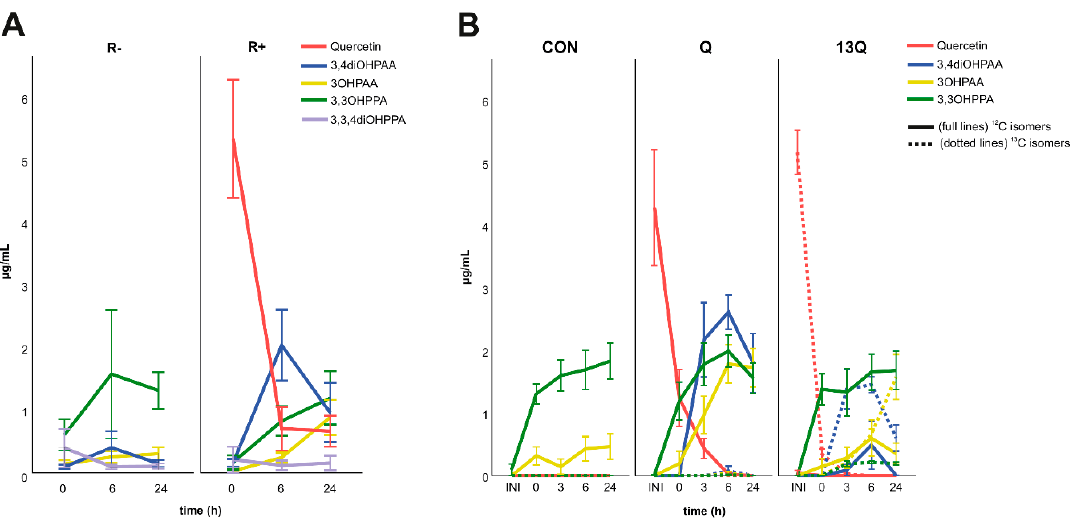
Figure 2. ( A ) Catabolic products of rutin in fermentations without fibres. R + , fermentation with rutin, R-, corresponding control without rutin; ( B ) Catabolic products of rutin aglycone –quercetin. CON, without inoculum and quercetin, Q, quercetin, 13Q, 13 C all-labelled quercetin isotope. Error bars denote S.E.M., n = 10 (for A), n = 4 (for B). INI, initial concentration added to vials (measured in a parallel sample without faecal inoculum).